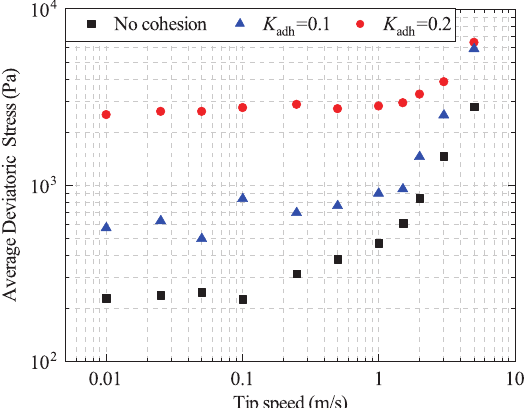
Fig. 3 DEM prediction of shear stress on the impeller blade of the FT4 rheometer as a function of impeller blade tip speed for glass beads for three adhesive indices accord- ing to the contact model of Luding (2008). Simulation data are from Vivacqua et al. (2019):